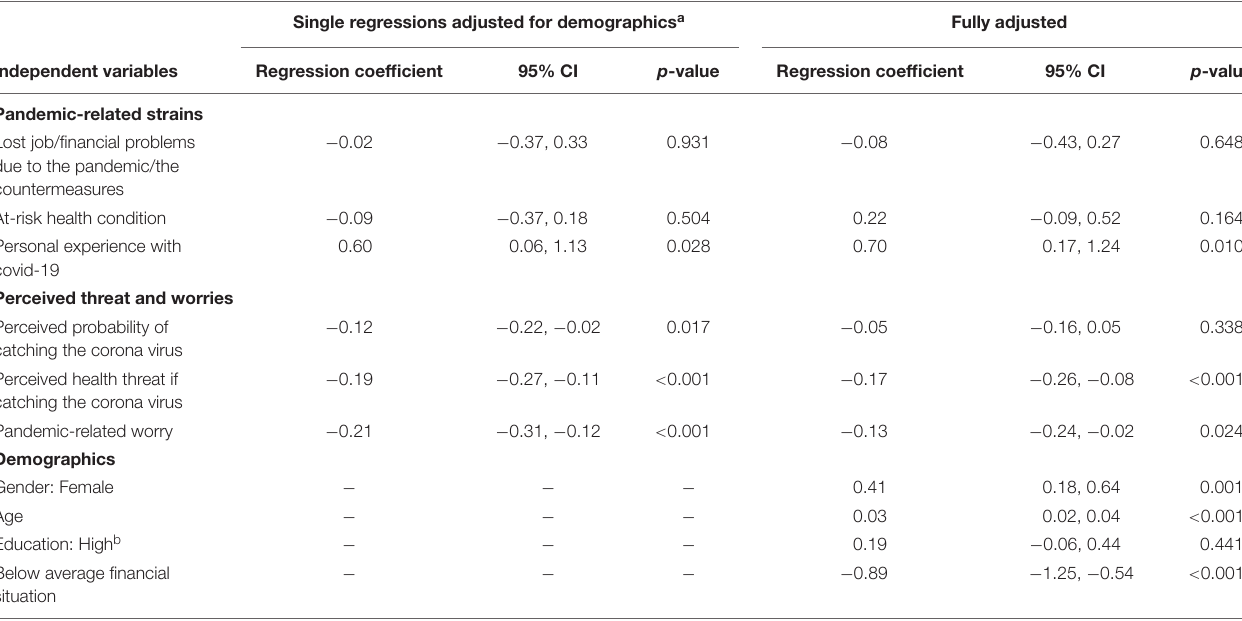
TABLE 2 | Associations between demographics, pandemic-related strains, perceived threat and worry, and generalized